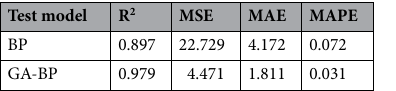
Table 6. Atomization model error